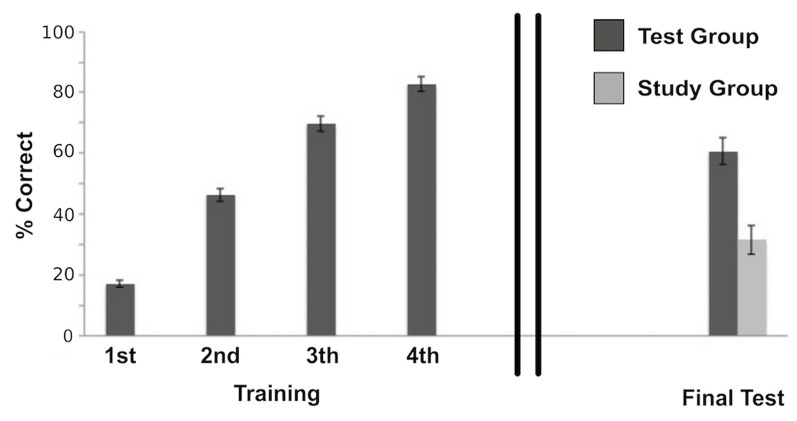
Behavioral performance of the Test group during the initial training session, which shows accuracy improvement across Test sessions (F(3,60) = 231.17, p < 0.001); and final test performances of both the Study group and the Test group after a 1-week delay, that shows a significant difference between groups (t(39) = 4.52, p < 0.001; Cohen’s d = 1.44) with a retrieval success twice as high for the Test group compared to the Study group. Error bars represent ± standard error of the mean.